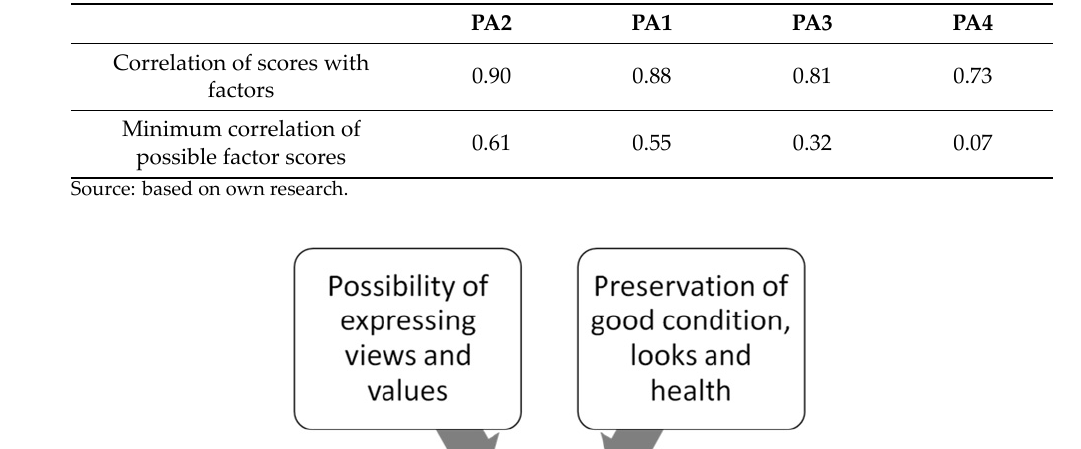
Table 1. Measures of factor score adequacy.